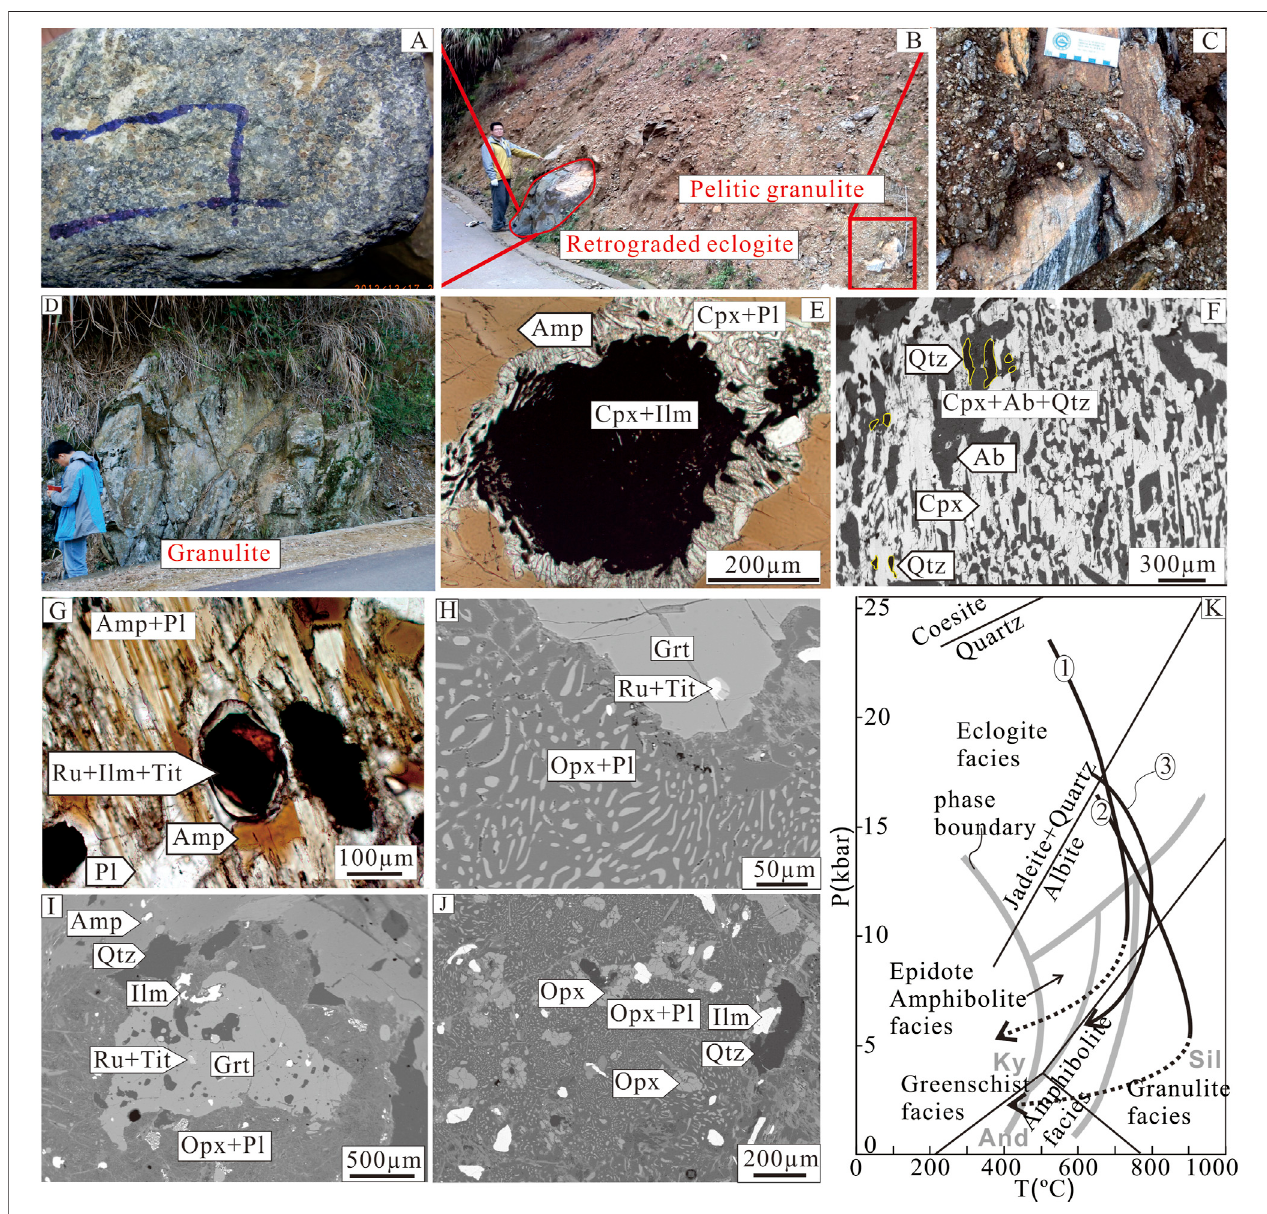
FIGURE 3 | Field photographs (A – D) , photomicrographs (E – J) showing fi eld occurrences, representative mineral assemblages and reaction textures, and P-T trajectoriesoftheIndosinianhigh-graderocks intheWuyiterraneoftheCathaysiaBlocks.Fieldand micrographicphotosarefromZhaoL.etal.(2018)and ZhaoL.etal. (2017). Numbers in (K) , 1 and 2 are P-T trajectories for retrograded eclogite and ma fi c granulite samples, respectively (from Zhao L. et al., 2017); 3 is P-T trajectory for retrograded eclogite presented by Xia et al. (2021). Mineral abbreviates, Amp, amphibole; Cpx, clinopyroxene; Pl, plagioclase; Ilm, ilmenite; Qtz, quartz; Ab,